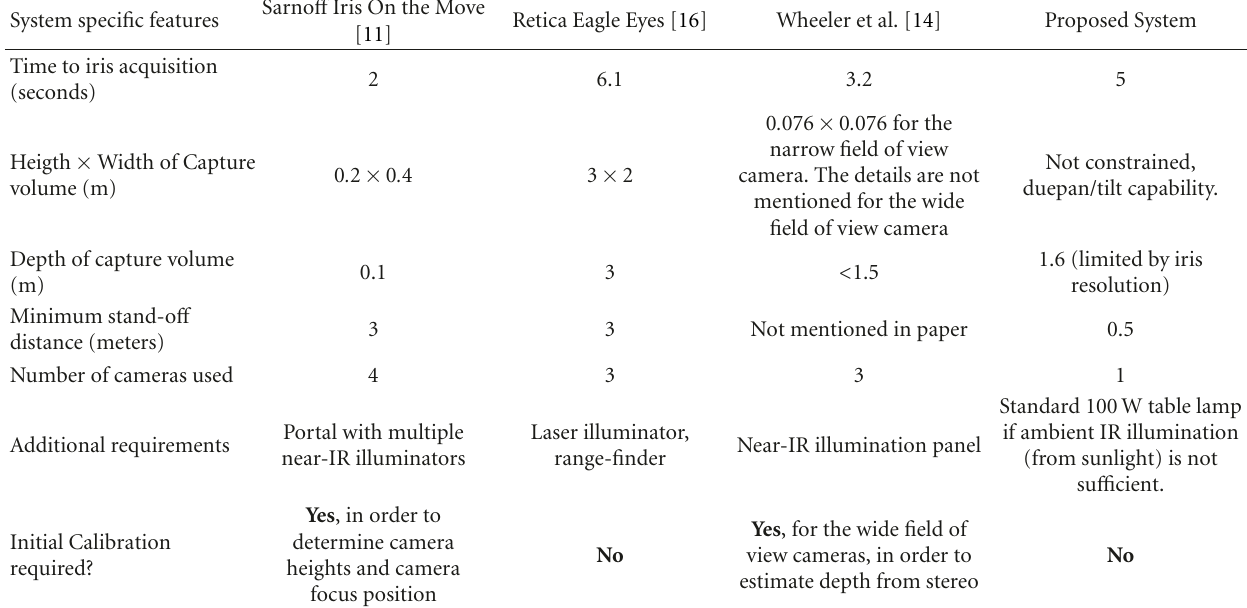
Table 2: Comparison of relevant features of the proposed system with other state of the art